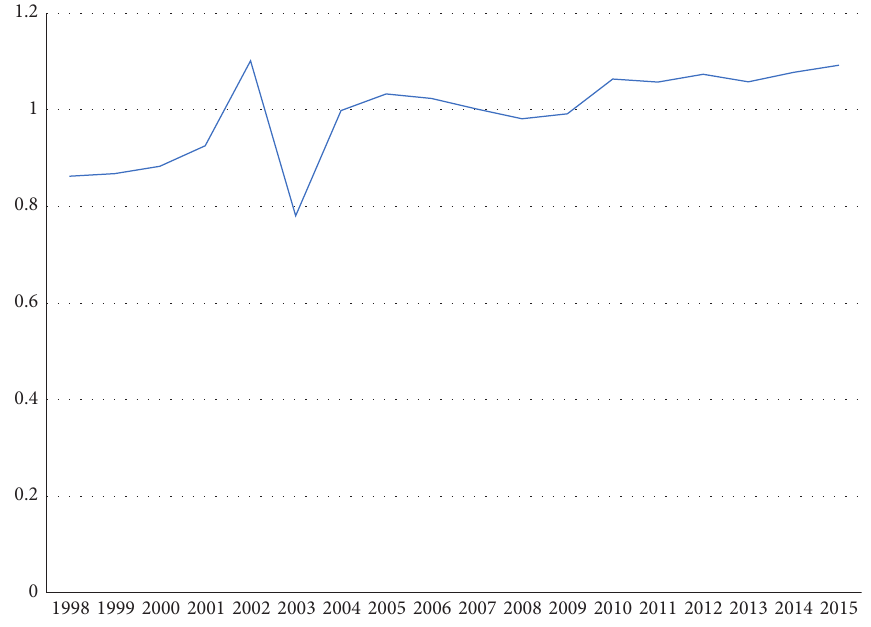
Figure 2: The price index of Hainan’s fruits from 1998 to